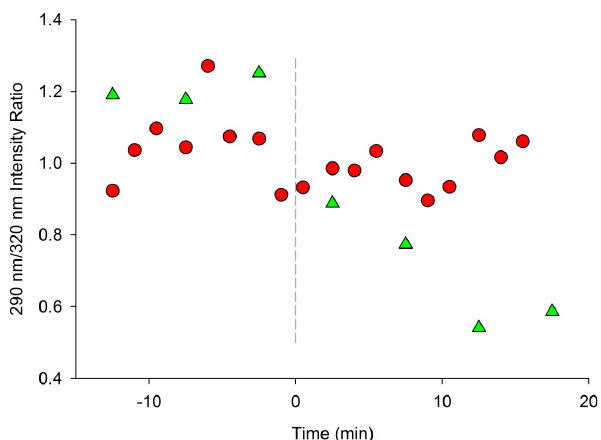
Fig. 3. The harmine 290/320 intensity ratio measured at the frozen freshwater surface (red circles) and at the frozen salt wa- ter (0.5MNaCl) surface (green triangles) as a function of time. The dashed line indicates the time ( t = 0) at which a 0.5 SLPM flow of 100 ppm of HCl in N 2 was introduced to the chamber. The pre- freezing pH of the samples was adjusted with NaOH(aq) to a pH ∼ 9.8. The final melted pH of the freshwater sample was ∼ 3 and the final melted pH of the salt water sample was pH ∼